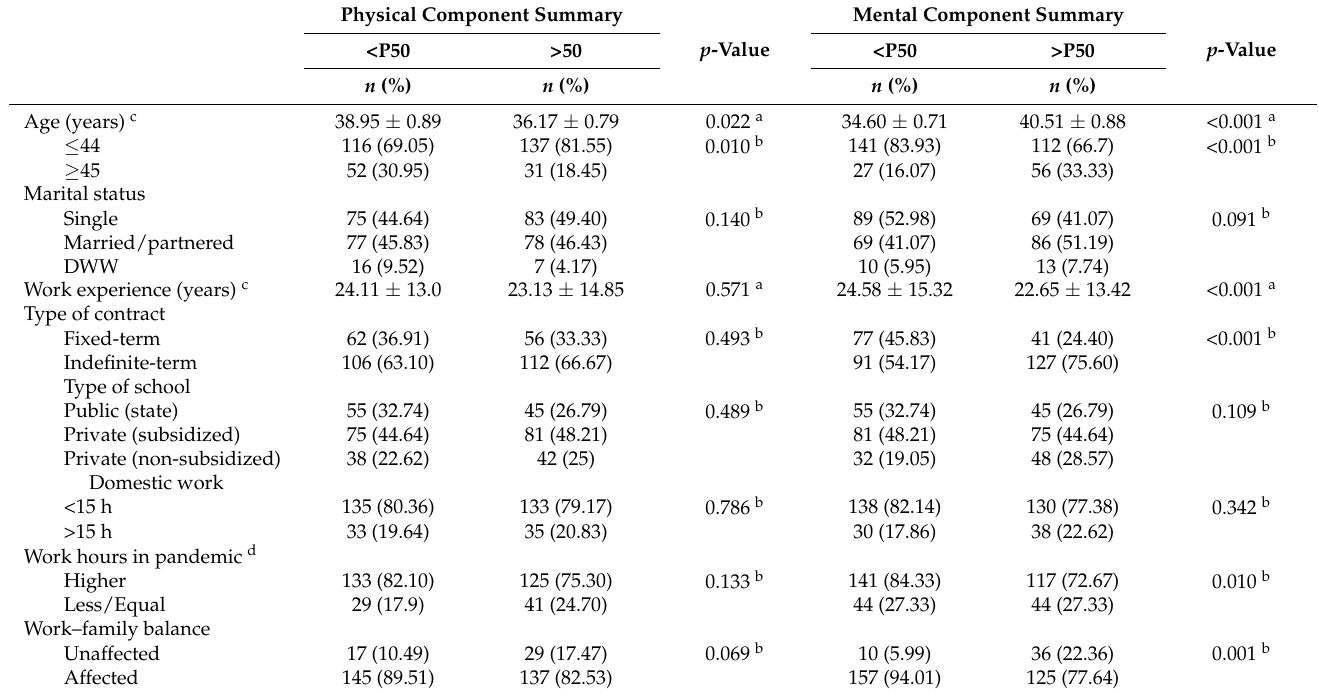
Table 2. Sociodemographic and working characteristics of Chilean teachers separated by PCS (Physical Component Summary) and MCS (Mental Component Summary) scores below 50th percentile and above 50th